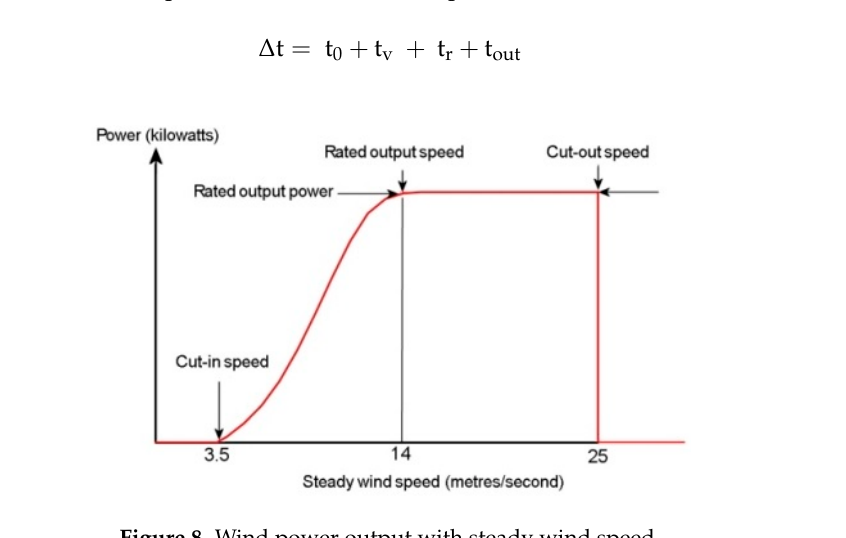
Figure 7. Yearly wind speed variation. According to this statistic, time of wind speed can be divided into three categories of duration: